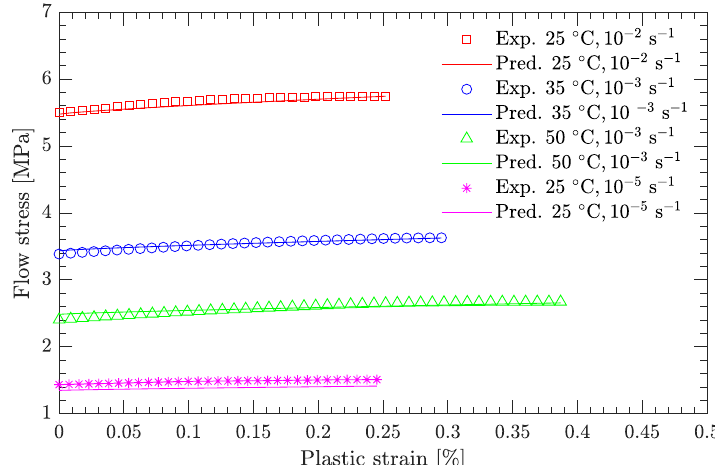
Figure 13. Comparison of predicted and measured flow stresses under static compression.